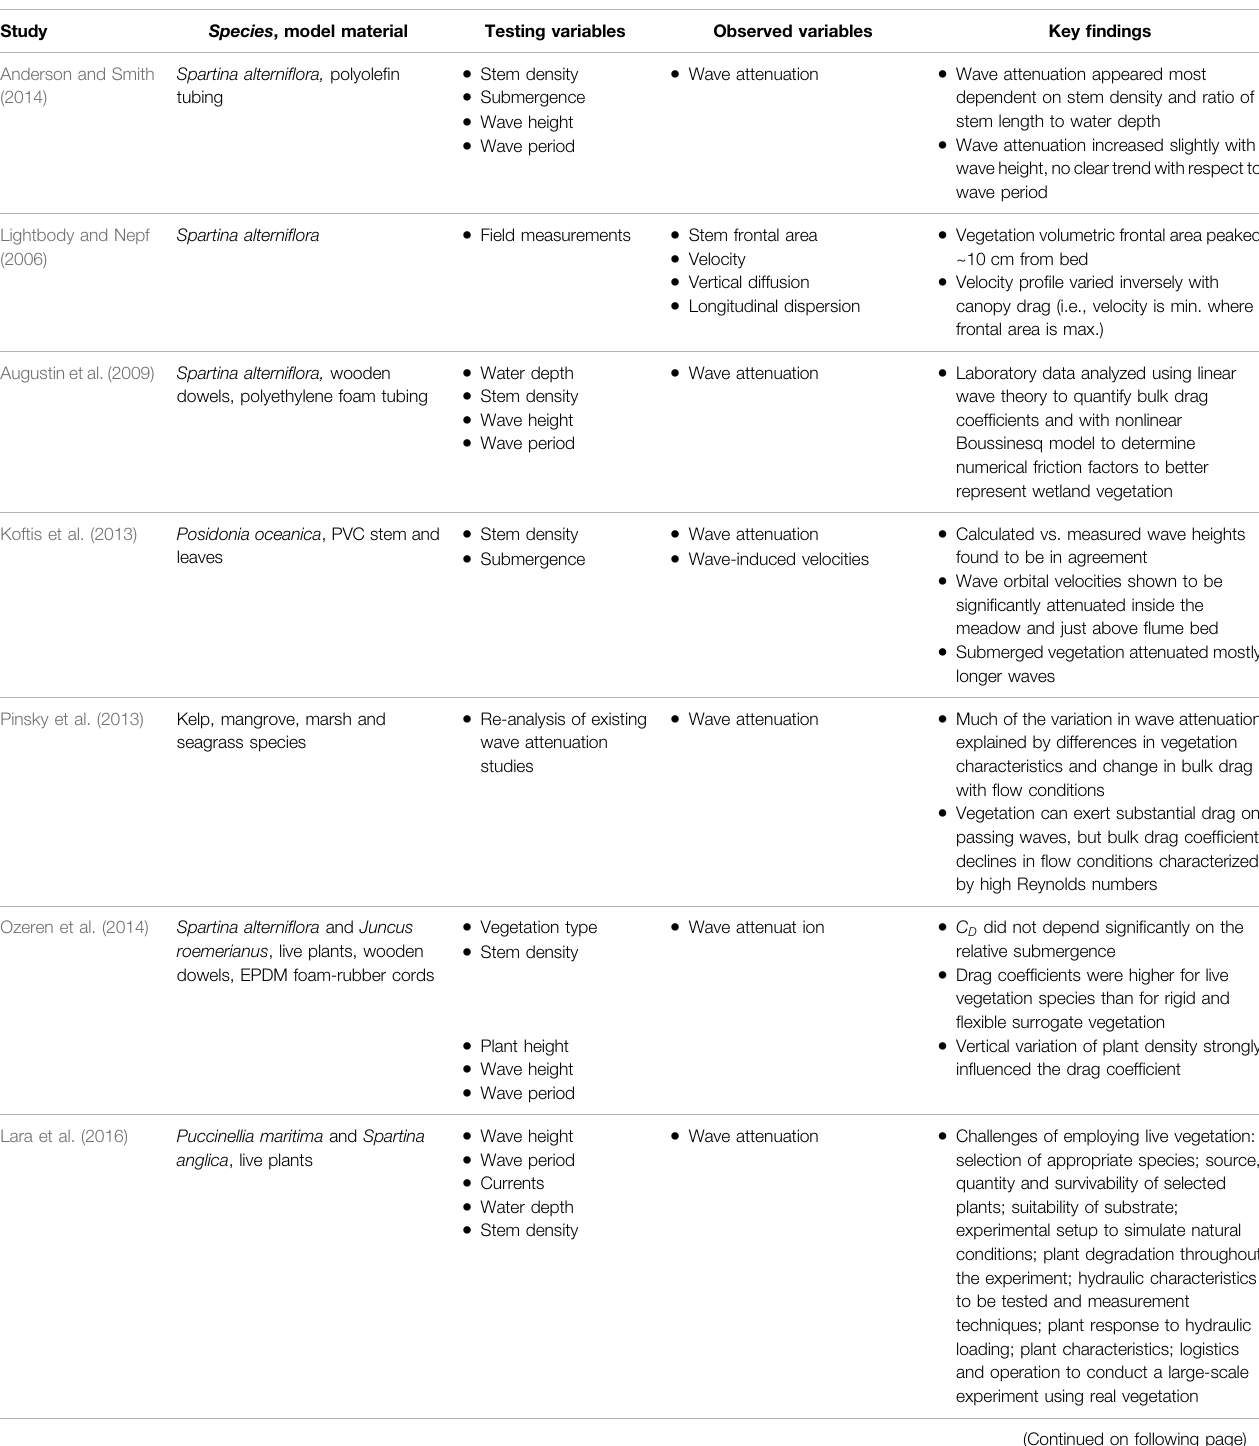
TABLE 1 | Summary of previous experimental studies with marsh